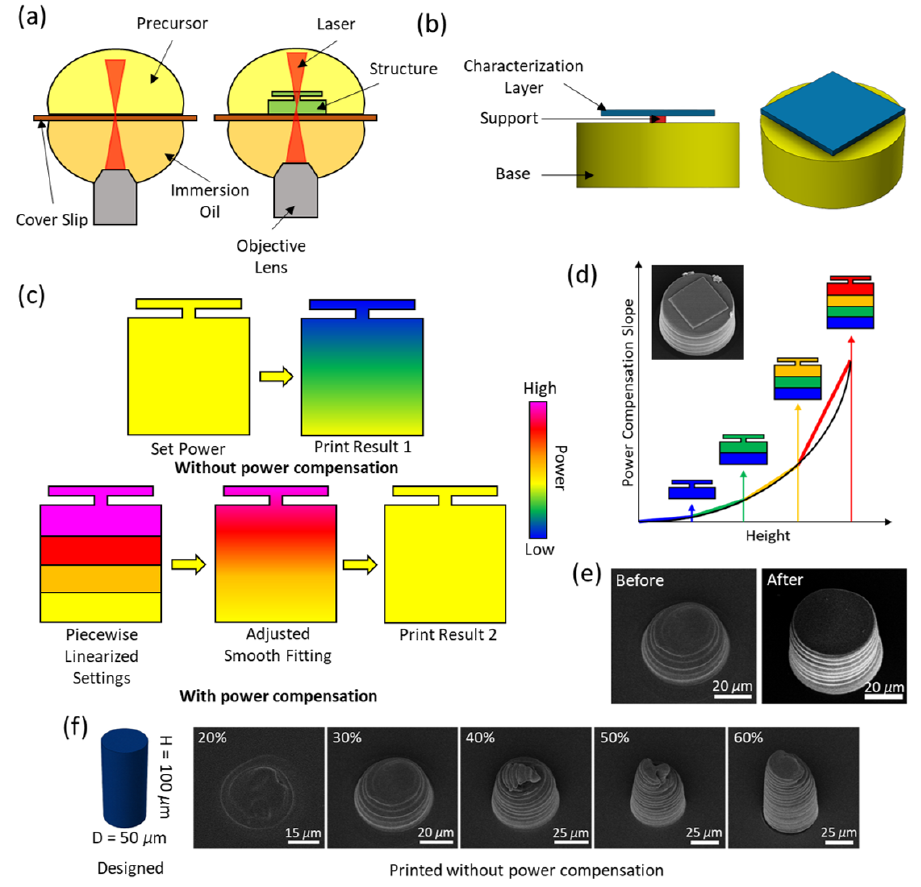
Figure 1. Schematic of polymerization decay in TPP with the oil-immersion mode. ( a ) Schematic of the two-photon polymerization process with the oil-immersion mode. ( b ) Model design for the characterization study of the power decay. ( c ) Route from the original sample to the compensated one. ( d ) Step-wise power compensation using a piece-wise linear slope from a gradually increased height. ( e ) 100 µ m-tall pillar printed with an initial power of 30% before and after power compensation. The view of the images is tilted for 30 ◦ . ( f ) A cylinder printed with different powers without power